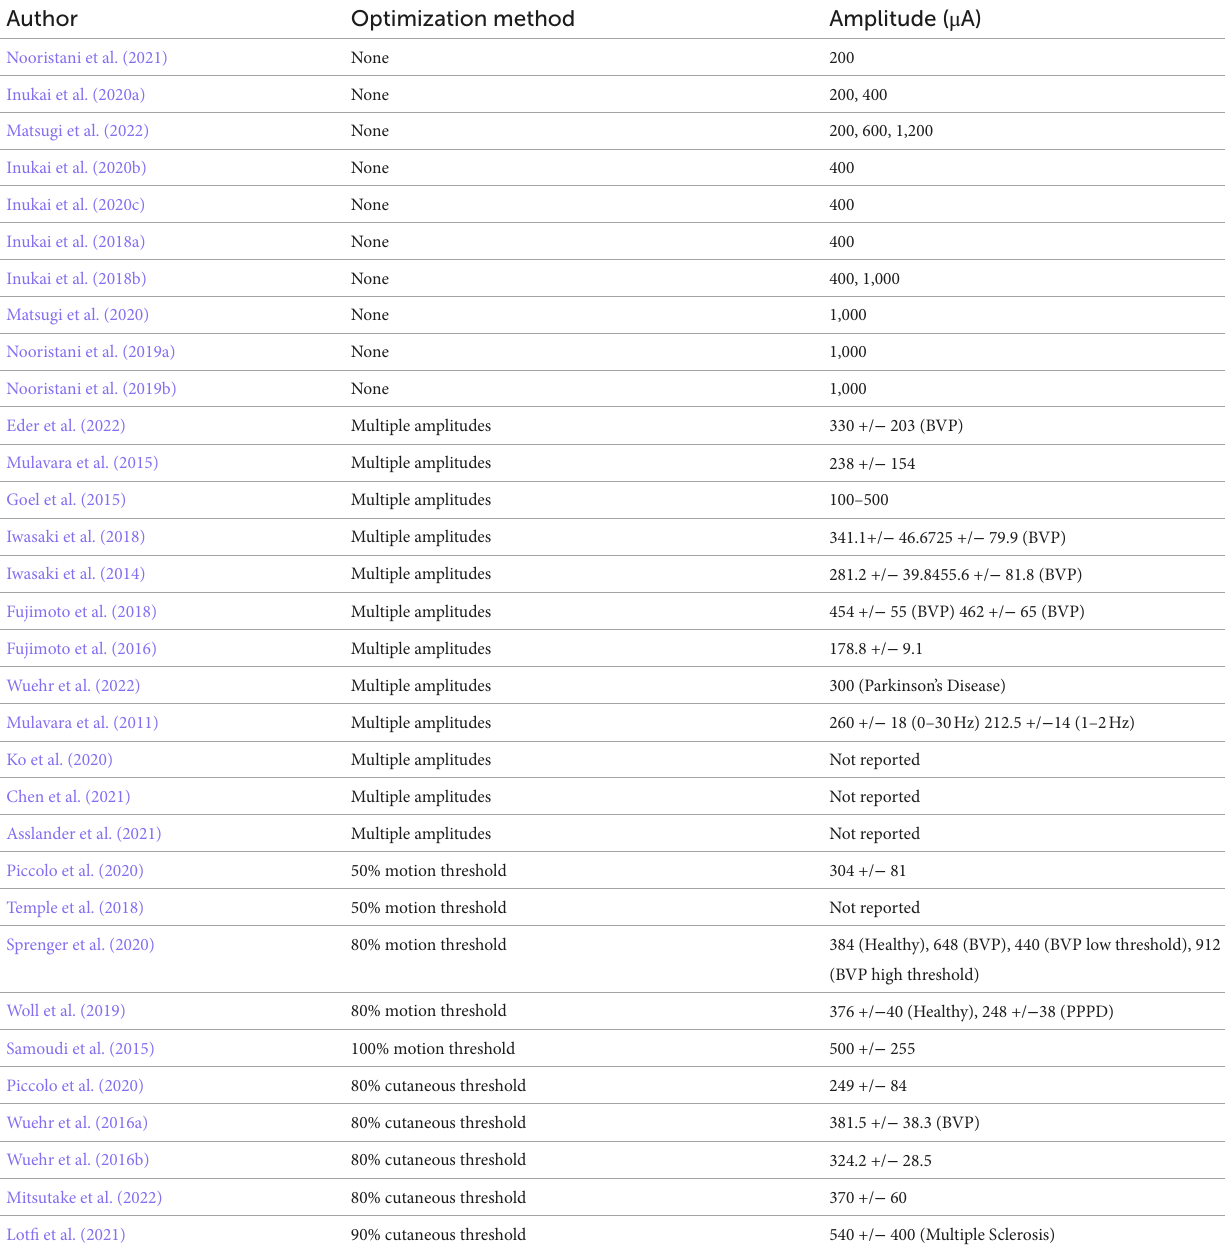
TABLE 5 Signal amplitudes and optimization methods used across